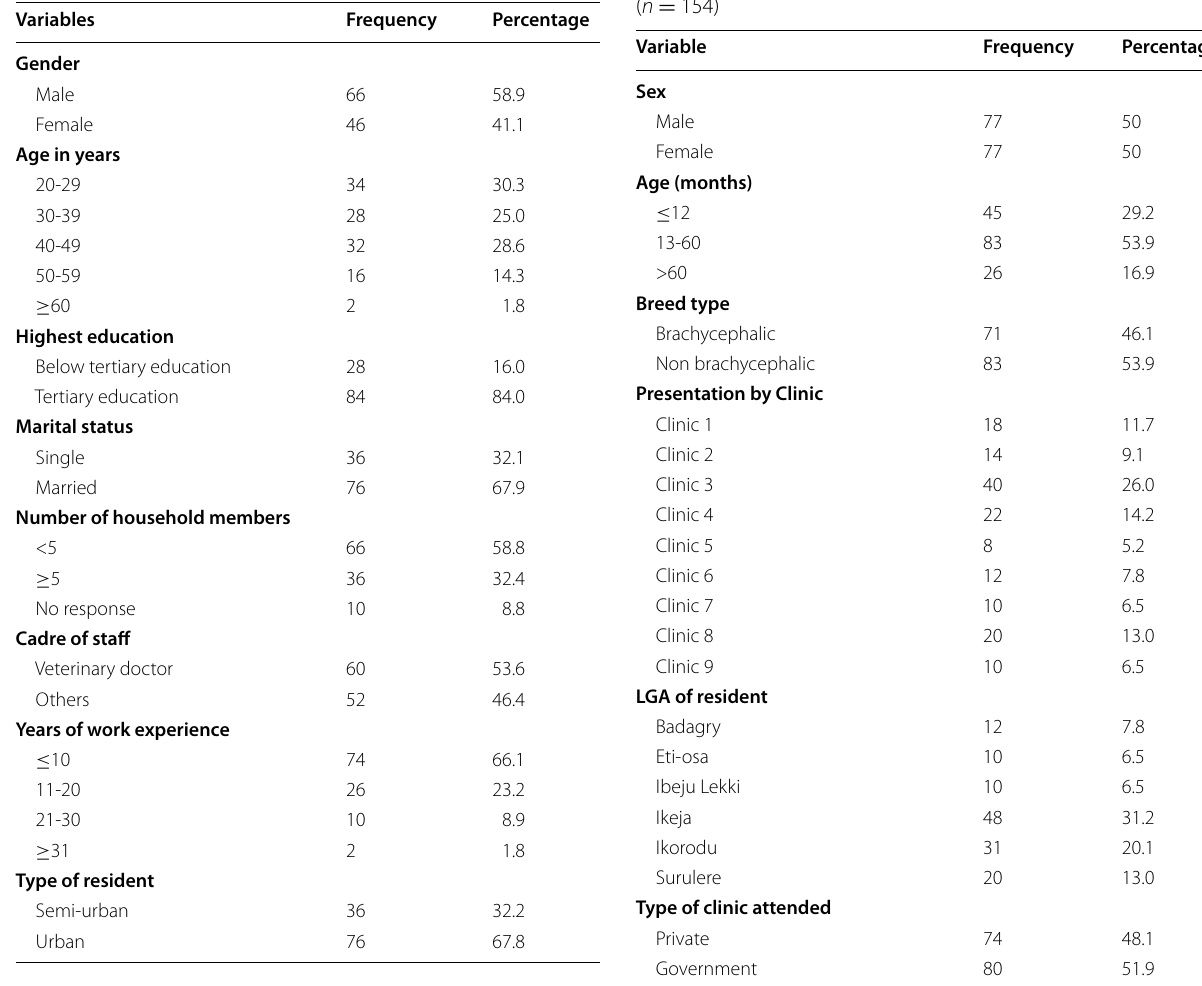
Table 1 Socio-demographic profile of respondents in the study Table 2 Demographic profile of dogs presented to